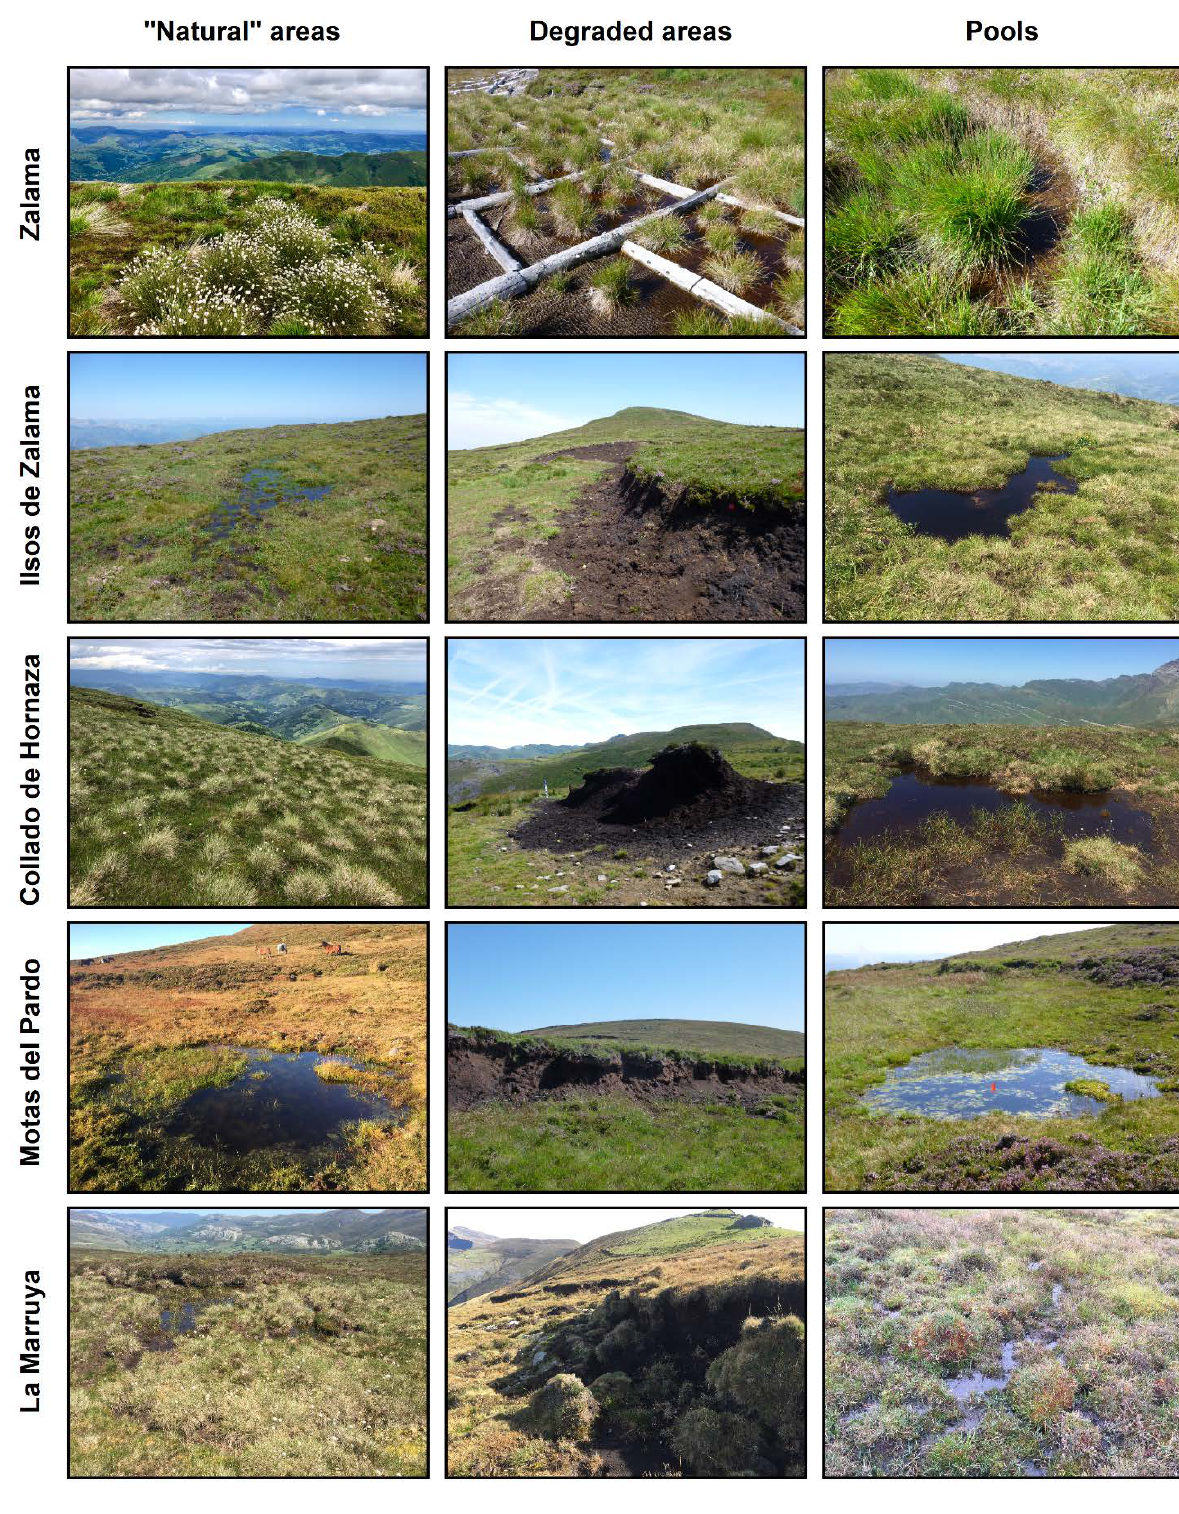
Figure 2. Ground level photographs of each site showing the “natural” area, degraded area and